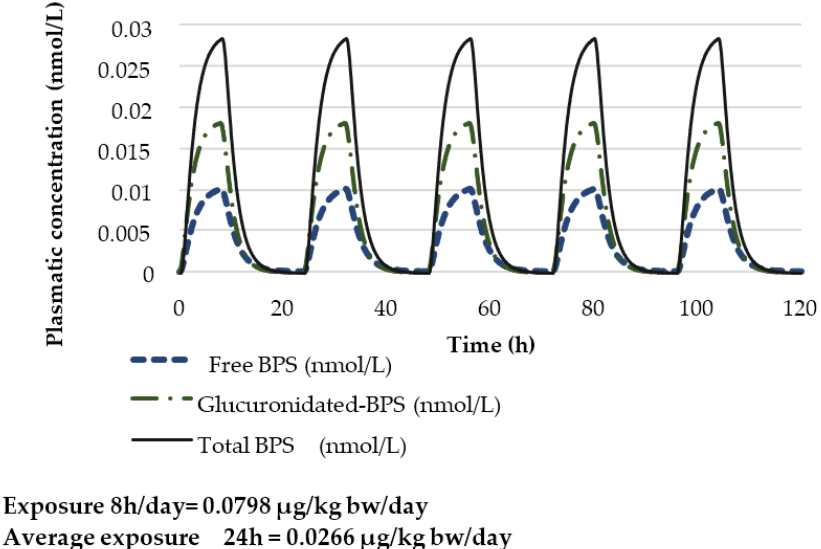
Figure 4. Estimated free BPS and glucuronidated BPS plasmatic concentrations (nmol/L) for an adult of 70 kg considering an occupational scenario lasting 5 days with daily exposure from 0 h to 8 h to 0.0798 µg/kg bw and from 8 h to 24 h to 0 µg/kg bw corresponding to an exposure for the entire day (0–24 h) of 0.0266 µg/kg bw/day.